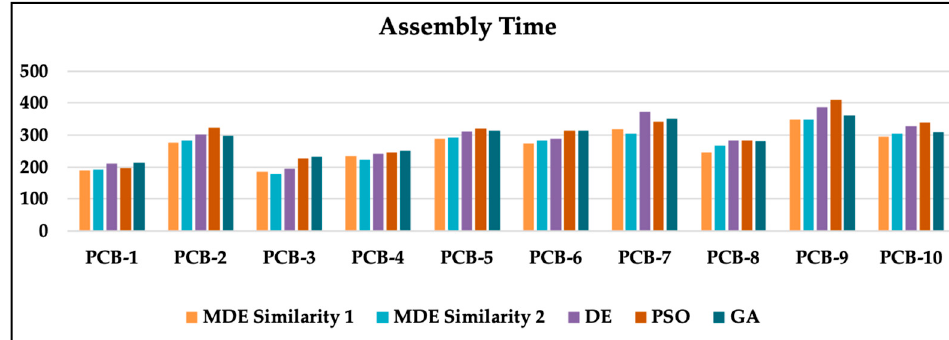
Figure 23. Bar chart of assembly times for each PCB.